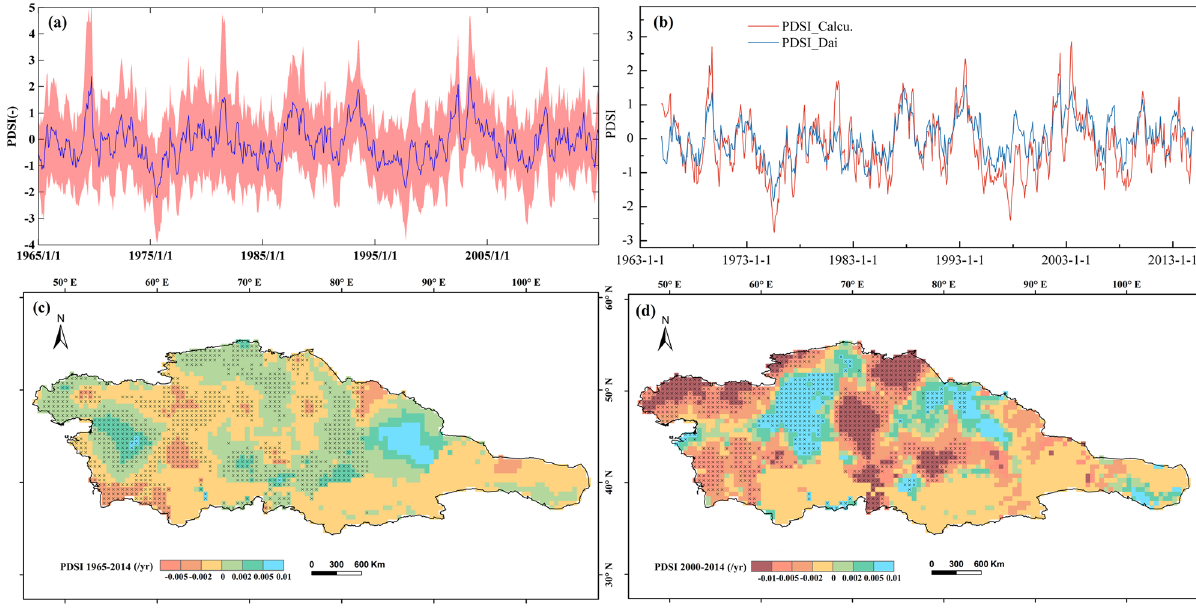
Figure 1. Spatio-temporal changes in the recent droughts over Central Asia during 1965–2014. ( a ) time series of the PDSI; ( b ) comparison of calculated PDSI to Dai’s result; ( c ) spatial trend of PDSI during 1965–2014; ( d ) spatial trend of PDSI during 2000–2014. (Generated by ArcGIS 10.2, URL: http://www.esri.com/software/ arcgis/arcgis-for-desktop, and Matlab 2012a, URL: